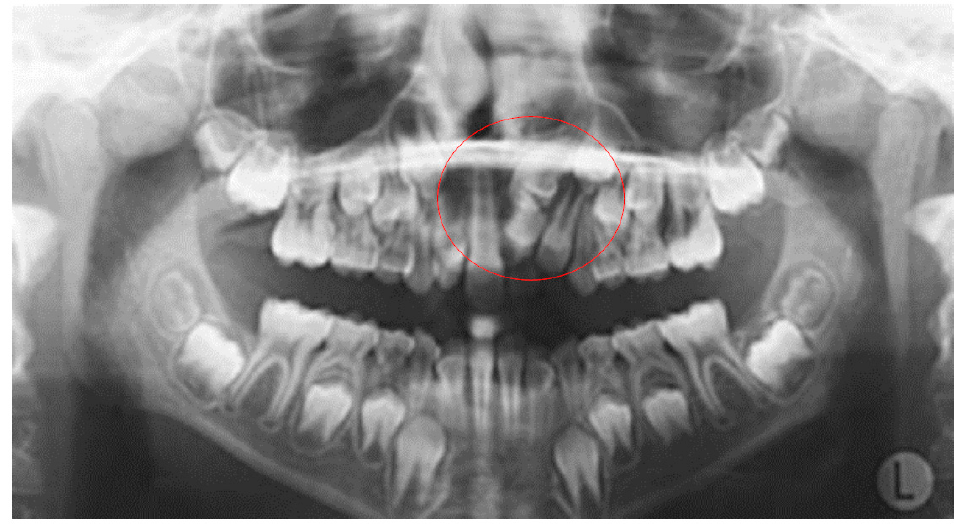
Figure 3. Ectopic eruption of upper left canine.